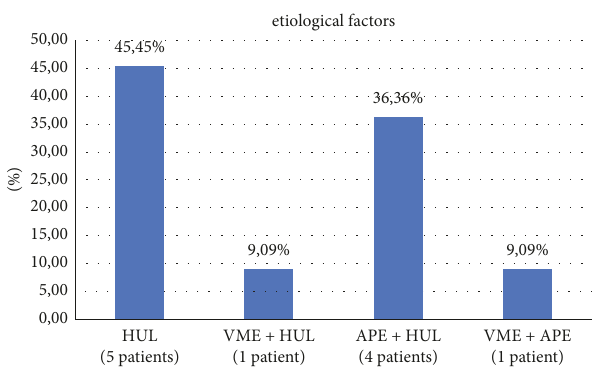
Figure 2: Representative graph of etiological factors identified in the sample